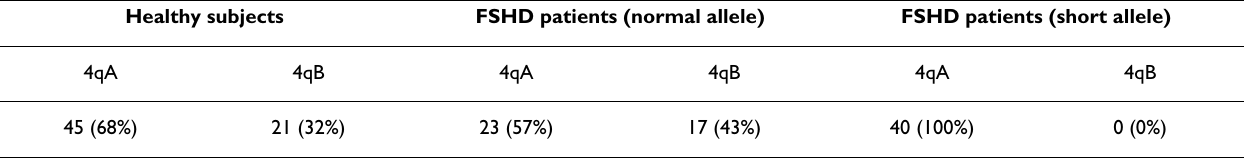
Table 2: Typing of qA and qB telomeres of 4q alleles from healthy subjects and FSHD patients Healthy subjects FSHD patients (normal allele) FSHD patients (short